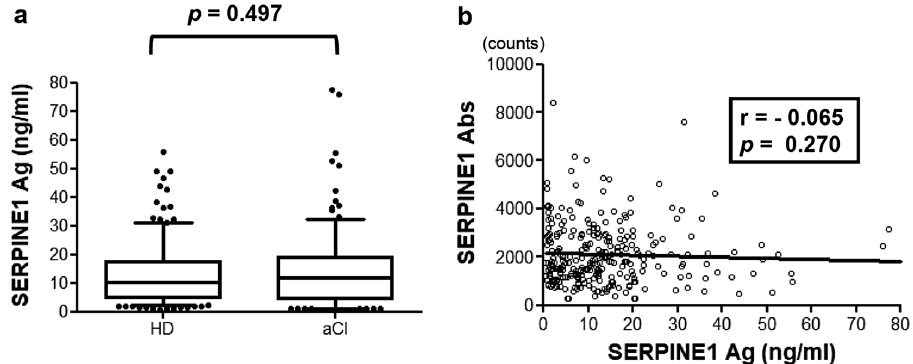
Figure 5. Comparison of serum SERPINE1 antigen levels between the aCI and HDs groups. ( a ) Serum SERPINE1 antigen levels were examined using sandwich enzyme-linked immunosorbent assay in healthy donors and patients with acute cerebral infarction. The results are shown in a box-whisker plot. The p values were calculated using the Kruskal–Wallis test. ( b ) SERPINE1 antibody levels were plotted against SERPINE1 antigen levels in a scattered plot. The correlation coefficient ( r value) and p value were calculated using the Pearson product–moment correlation